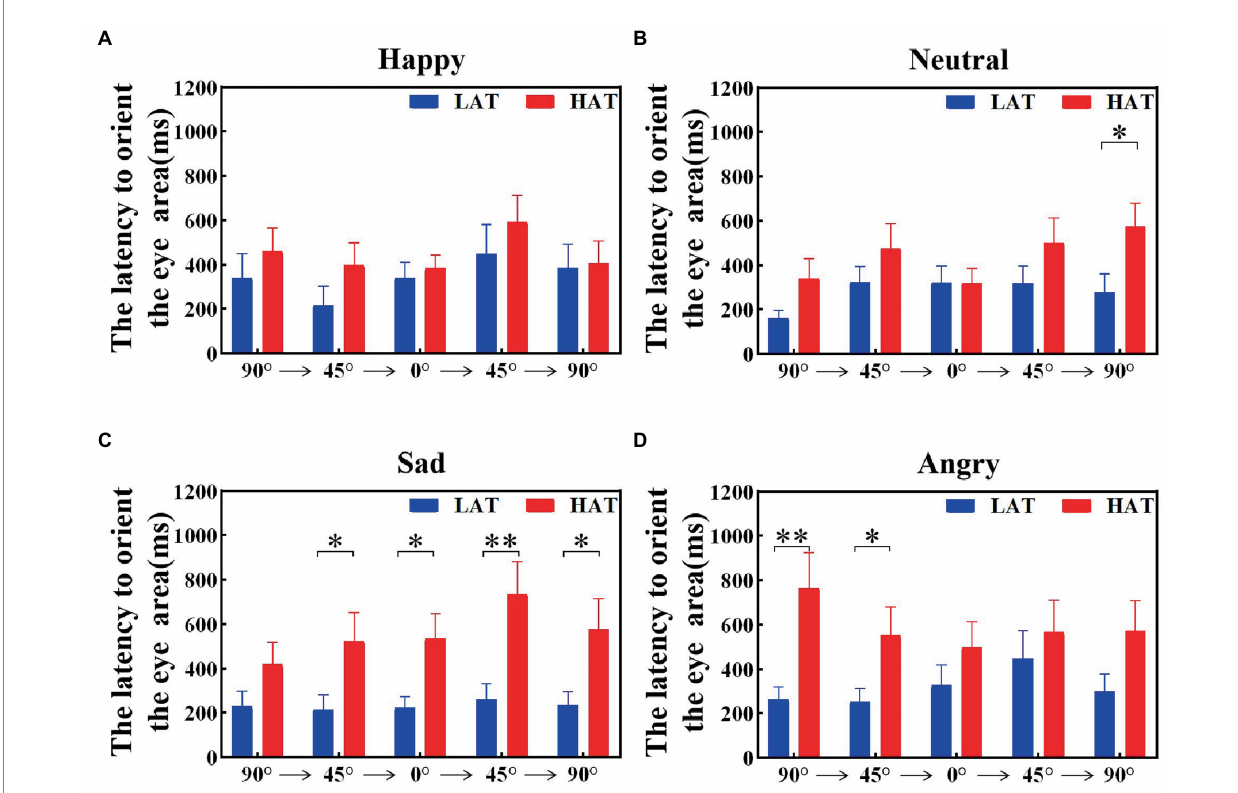
FIGURE 5 The latency to orient the eye area of the HAT and the LAT groups during the observation of happy (A) , neutral (B) , sad (C) , and angry (D) emotional faces with different angles under the ‘Side-Front-Side’